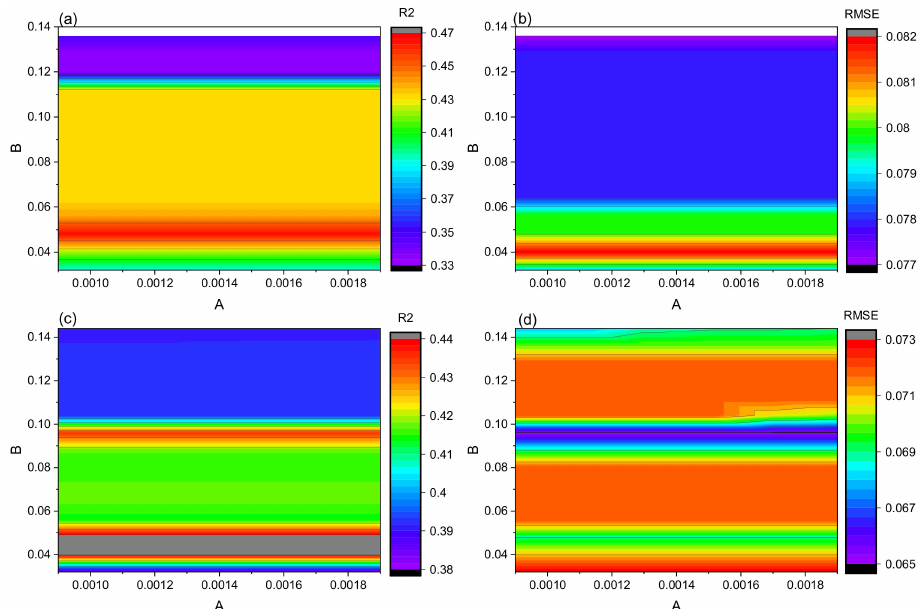
Figure 5. Error metrics of soil moisture retrievals from the SCA-VV scheme under di ff erent parameter settings. ( a , b ) show the R 2 and RMSE of soil moisture retrievals at the COSMOS029 site, while ( c , d ) show the R 2 and RMSE of soil moisture retrievals at the COSMOS099